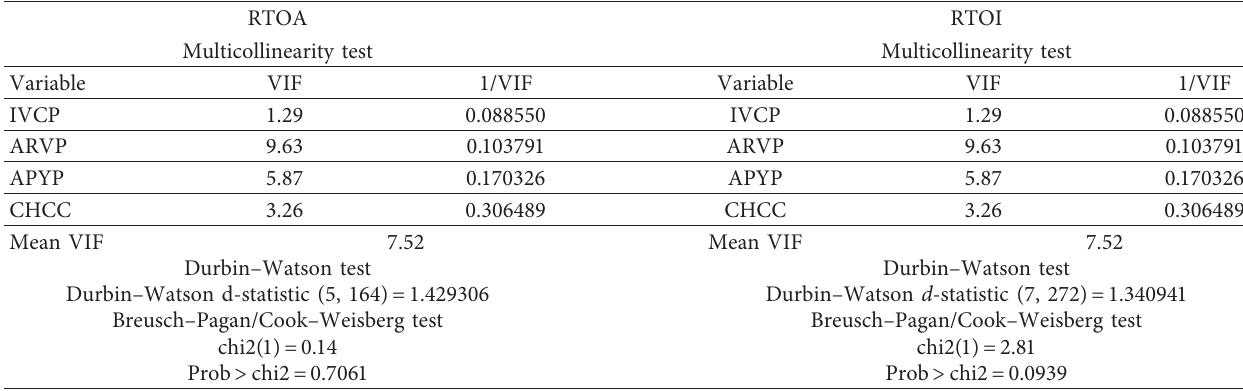
Table 3: Multicollinearity test, test of autocorrelation, and test of heteroscedasticity.